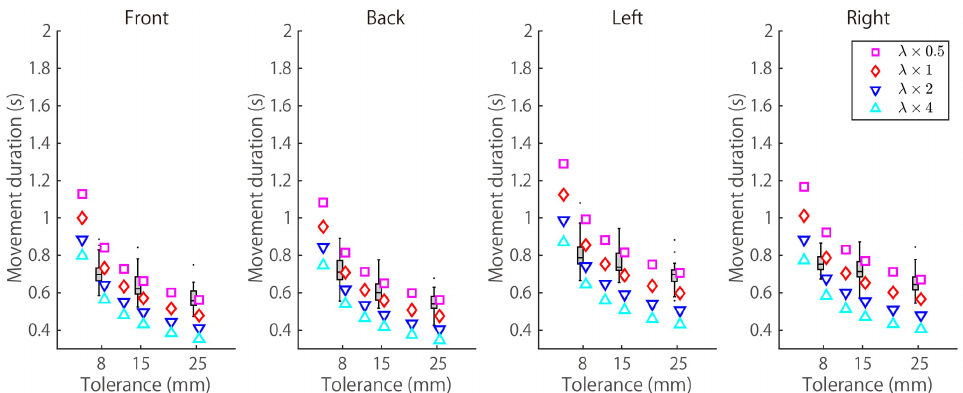
Figure 8. Median movement duration profiles obtained by the model when λ is changed in × 0.5, × 1, × 2, and × 4 (the base values of λ are shown in Table 3). The results of a representative subject (subject A) are